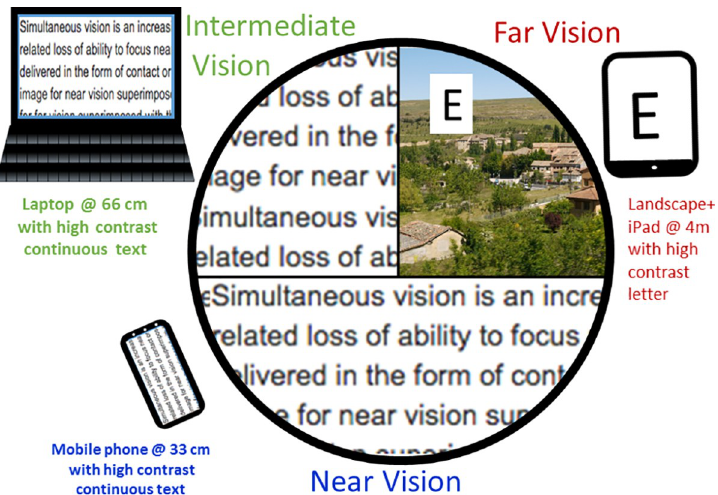
Fig 2. Composite high resolution visual scene for perceptual preference measurements was composed using landscape and high contrast letter (in iPad) for far (4m), and a high contrast text for intermediate distance on a laptop (66 cm) and near distance on a mobile phone (33 cm). The text and the scene is similar but not identical to the original image and is therefore for illustrative purposes only.